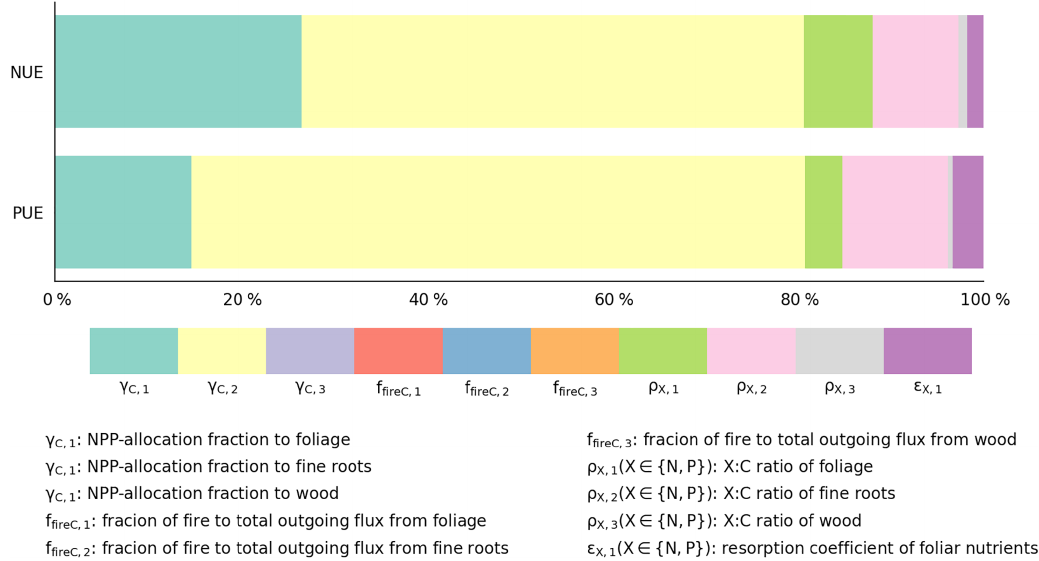
Figure 9. Contribution of input data to the variance in the estimates of nutrient-use efficiencies ( X ∈ { N , P } ) for temperate coniferous forests; γ C ,i = 1 , 2 , 3 are NPP-allocation fractions to foliage, fine roots, and wood, respectively. f fireC ,i = 1 , 2 , 3 are fractions of fire to total outgoing flux from foliage, fine roots, and wood, respectively. ρ x,i = 1 , 2 , 3 ( X ∈ { N , P } ) are X :C ratios of foliage, fine roots, and wood, respectively. ε X, 1 ( X ∈ { N , P } ) is the resorption coefficient of foliar